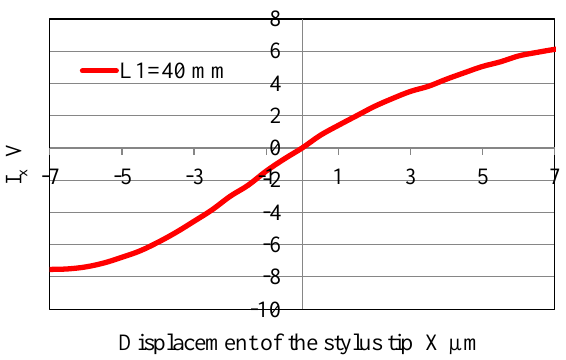
Figure 9. Output voltage of I Y for a distance L 1 = 40 mm ( X displacement of the stylus tip).